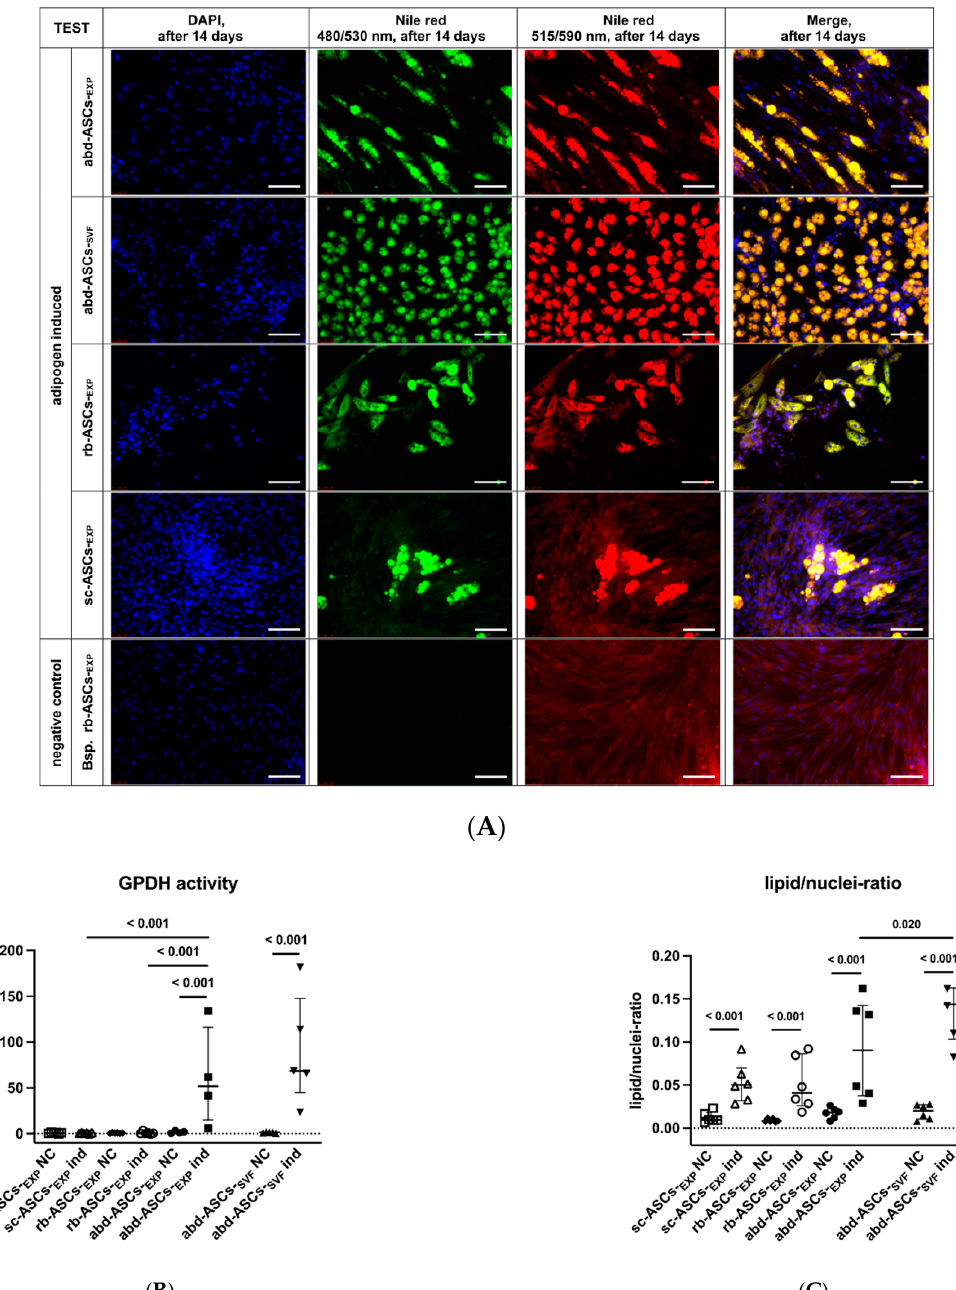
Figure 3. Adipogenic di ff erentiation. ( A ) Fluorescence microscopic images of adipogenically induced equine adipose-derived stem cells (ASCs) after Nile red and DAPI staining of one representative horse on day 14. Preadipocyte di ff erentiation was induced in ASCs harvested from abdominal (abd), retrobulbar (rb) and subcutaneous (sc) adipose tissue using the explant method (EXP) or using the stroma vascular fraction (SVF) after collagenase digestion. Cell nuclei were stained blue (DAPI), non-polar lipids green and total lipids red (Nile red). In all induced samples, except for non-induced negative control (NC), lipid droplets were detected. Scale bar: 100 µm (20× objective). ( B ) Glycerol-3- phosphate dehydrogenase (GPDH) activity and ( C ) Lipid/nuclei-ratio of adipogenically induced equine ASCs measured on day 14. NC were included in the experiment. Median values are shown with interquartile ranges as error bars ( n = 6). The p -values shown are from the Mann–Whitney U test (comparisons of isolation methods and treatment effects) or from the Kruskal–Wallis test (comparisons of adipose tissue